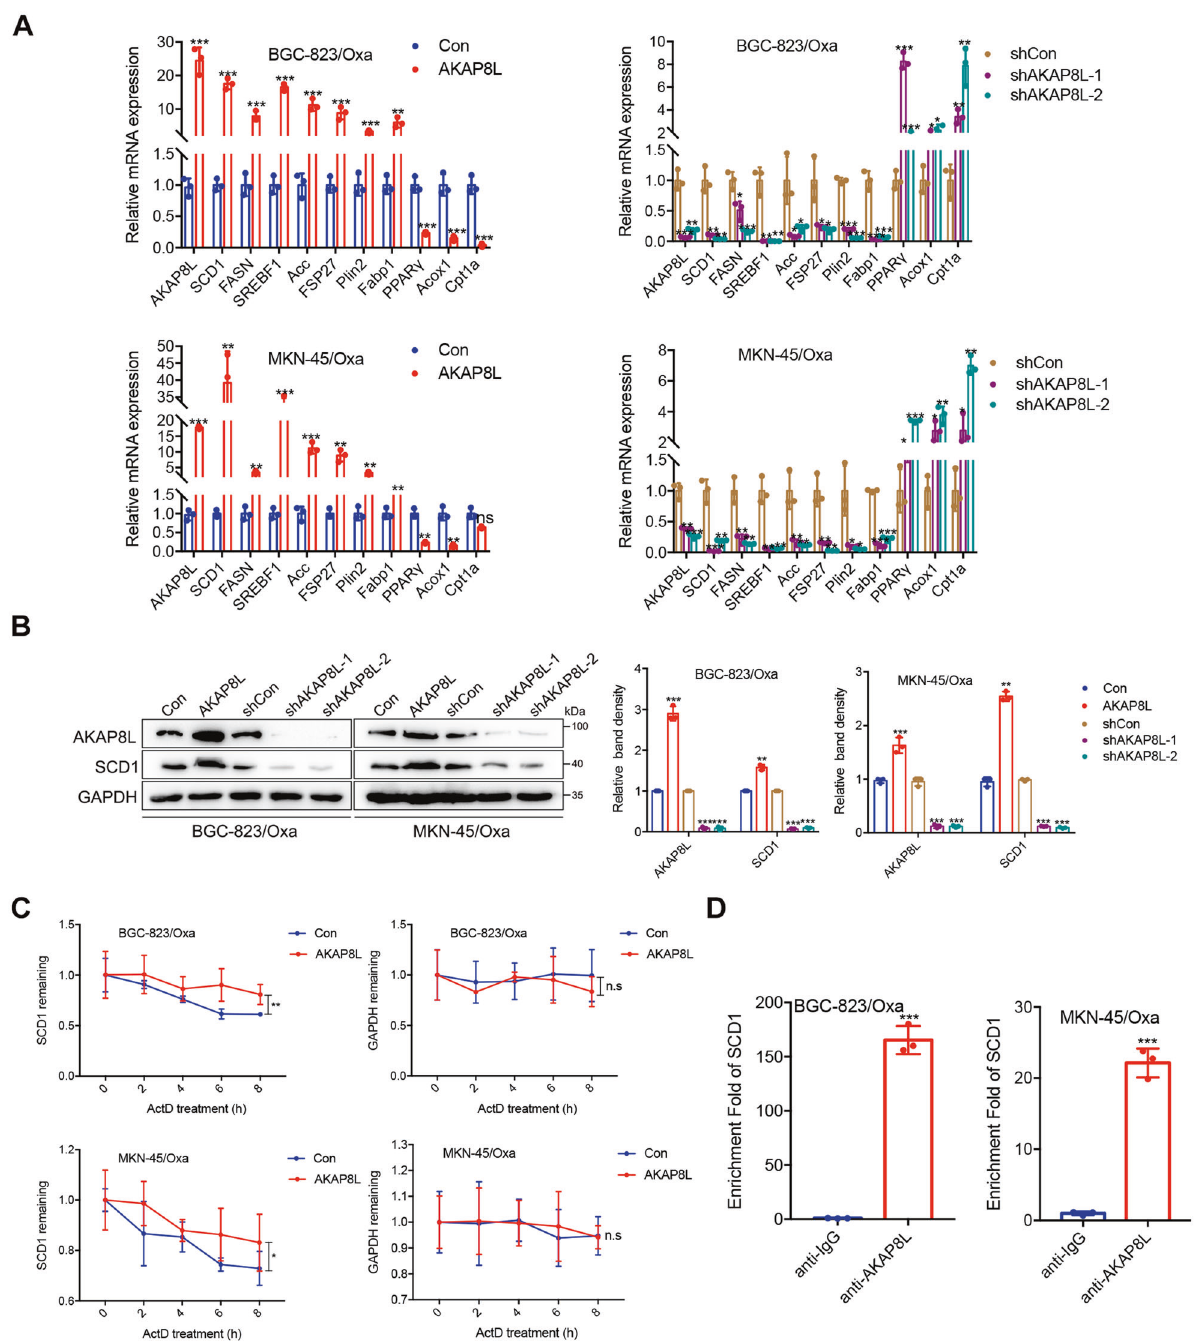
Fig. 5 AKAP8L upregulates SCD1 expression via mRNA stability. A qPCR assay showed the expression of lipid metabolism-related genes. B Western blot analysis showed the expression of SCD1 in AKAP8L or AKAP8L shRNA transfected GC cells. C BGC-823/Oxa or MKN-45/Oxa cells were transiently transfected with control or AKAP8L plasmid for 48 h and then treated with ActD for 0, 2, 4, 6, 8 h. The SCD1 mRNA level was determined using qPCR. The GAPDH mRNA level was used as a negative control. D RIP assay using total cell lysates of BGC-823/Oxa or MKN- 45/Oxa cells was used to assess the interaction between AKAP8L and SCD1 mRNA. Enrichment of SCD1 mRNA in the AKAP8L-containing immunoprecipitated particles was measured using qPCR and normalized to input. The values represent the mean ± SD of three independent experiments (* P < 0.05, ** P < 0.01, *** P < 0.001 independent Student ’ s t mRNA level and protein levels in xenograft tumors (Fig. S1A – E). protein levels. Consistently, the data from Kaplan – Meier plotter Inhibition of AKAP8L resulted in the downregulation of SCD1 in database (213155_at and 213157_s_at) also associated higher xenograft tumors (Fig. S1A – E). In conclusion, we con fi rmed that SCD1 expression levels with poor overall survival and fi rst AKAP8L and SCD1 were upregulated in gastric cancer patients progression (Fig. 8E, F). A schematic model showed the role of resistant to chemotherapy, consistent with the fi ndings the AKAP8L in GC stemness and Chemoresistance (Fig. 8G). In addition, ectopic AKAP8L upregulated the expression of SCD1 at